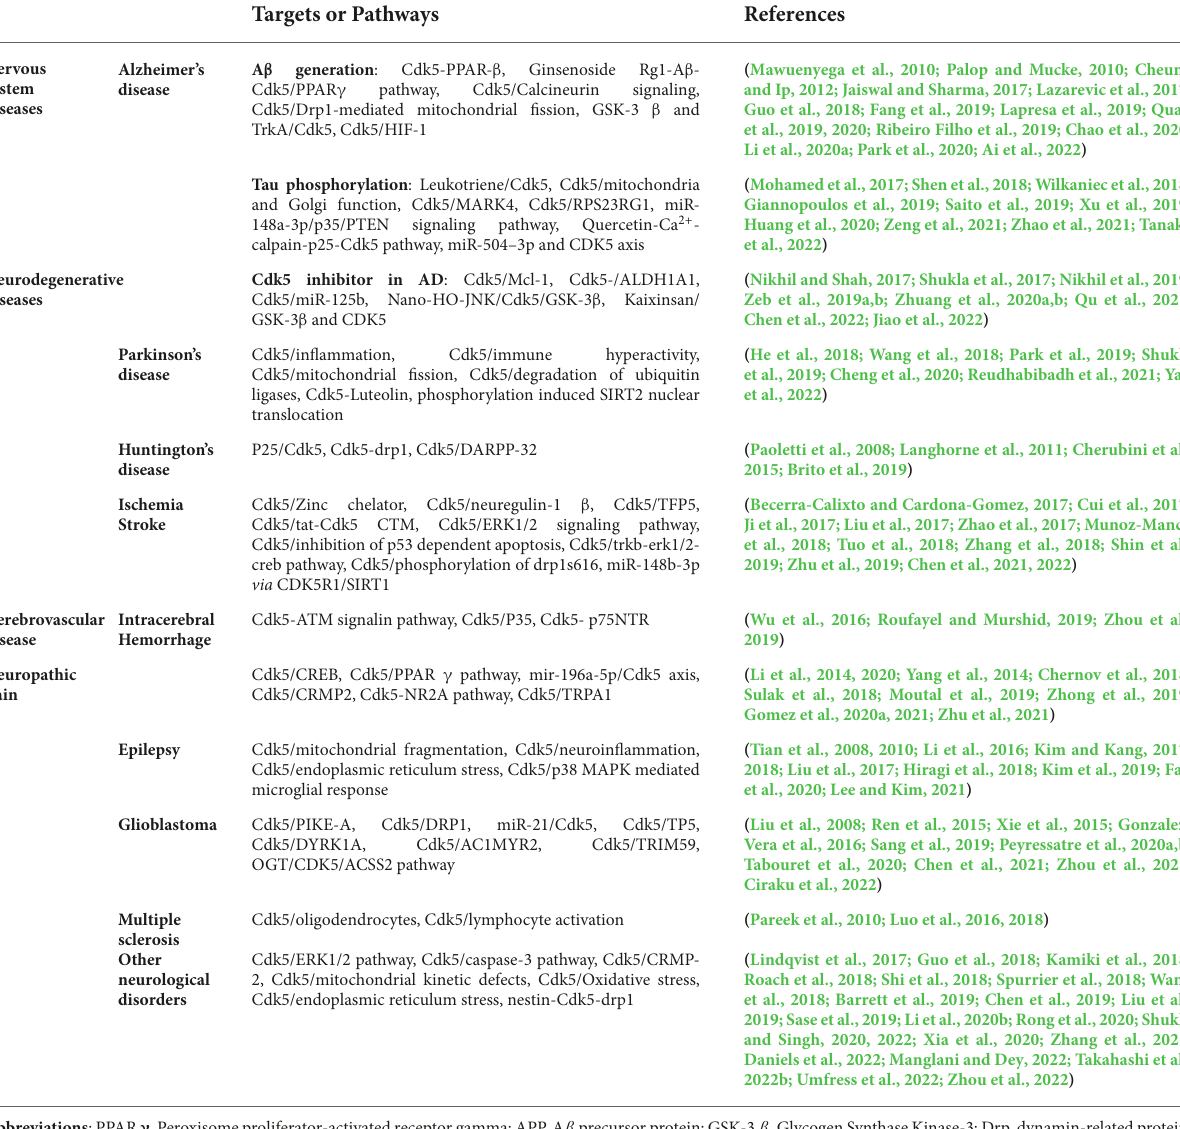
TABLE 1 Summary of the main targets of cdk5 in neurological diseases and mechanism of Cdk5 and nervous system diseases. Targets or